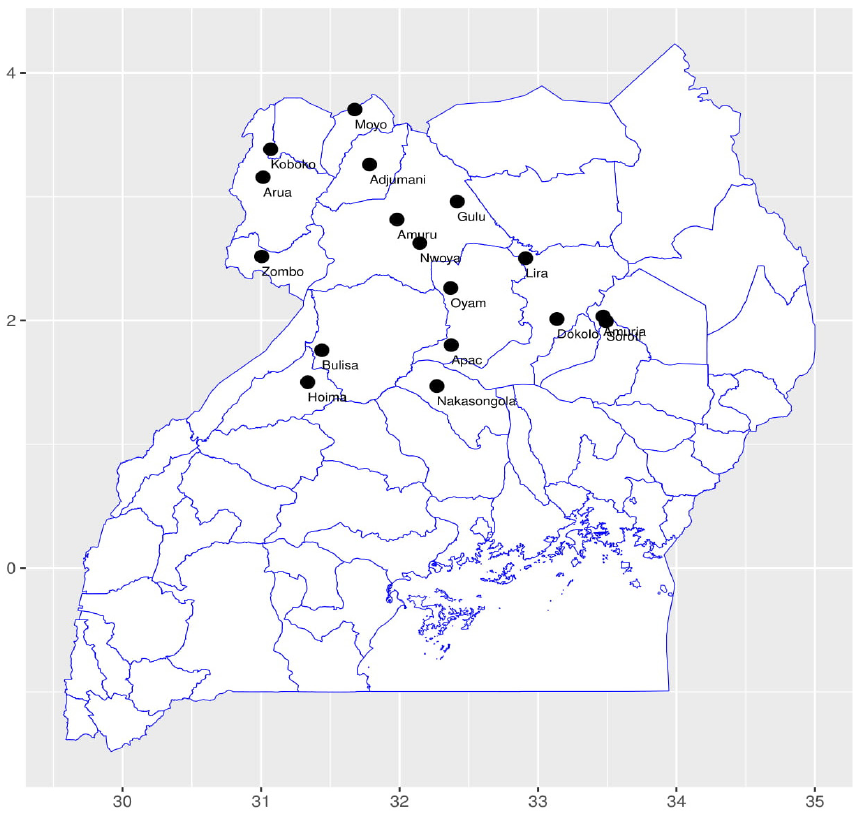
Figure 1. Districts of Uganda collection locations of bean leaf beetle samples used in the study. Table 2. Agro-ecological zones, number of samples of O. mutabilis and O. proteus found per agro- ecological zone after DNA barcoding with mt COI partial gene and Ugandan districts belonging to particular agro-ecological zones where bean leaf beetle samples were collected.